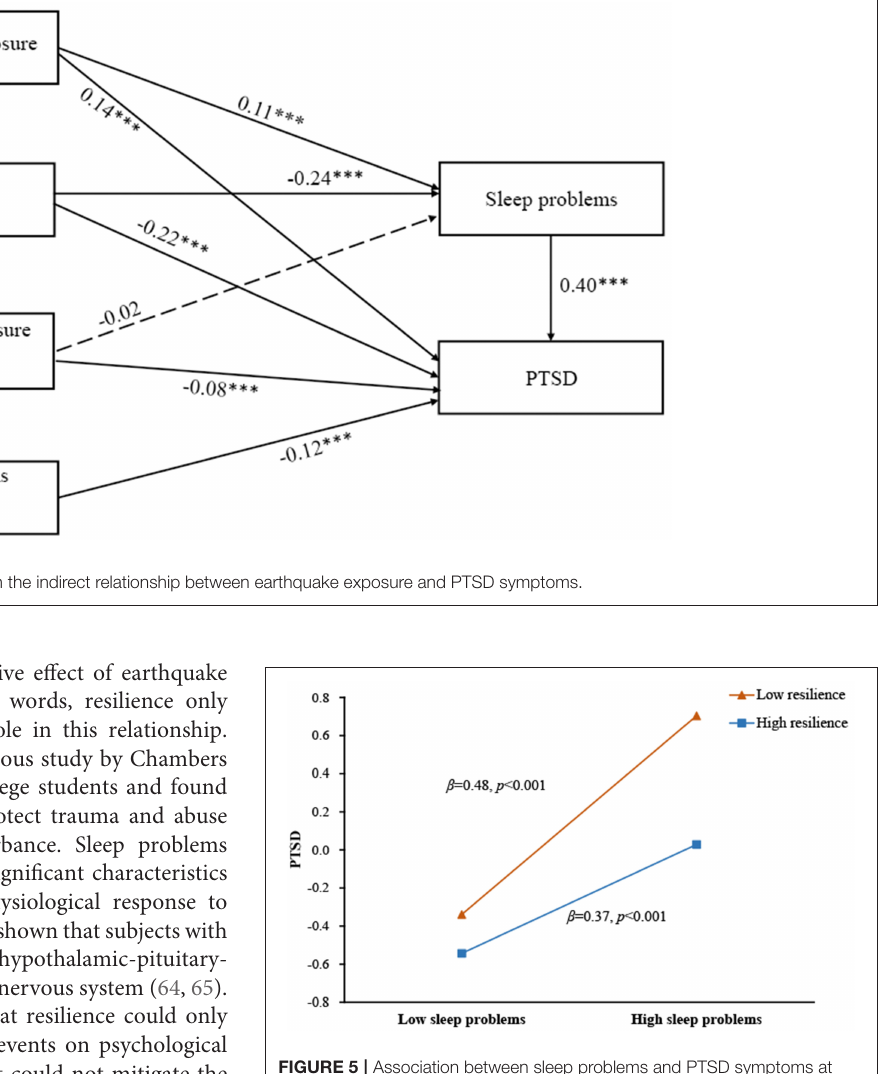
FIGURE 5 | Association between sleep problems and PTSD symptoms at higher and lower levels of